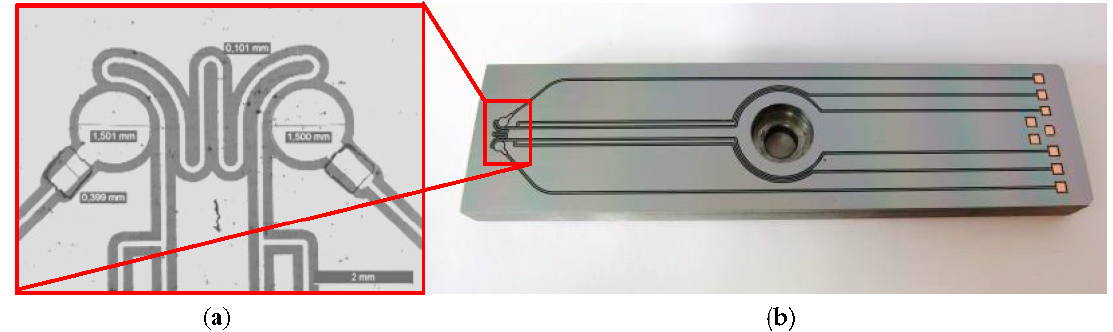
Figure 2. Photomicrograph of the three thermoresistive sensor structures is shown in ( a ) and the whole mold insert in ( b